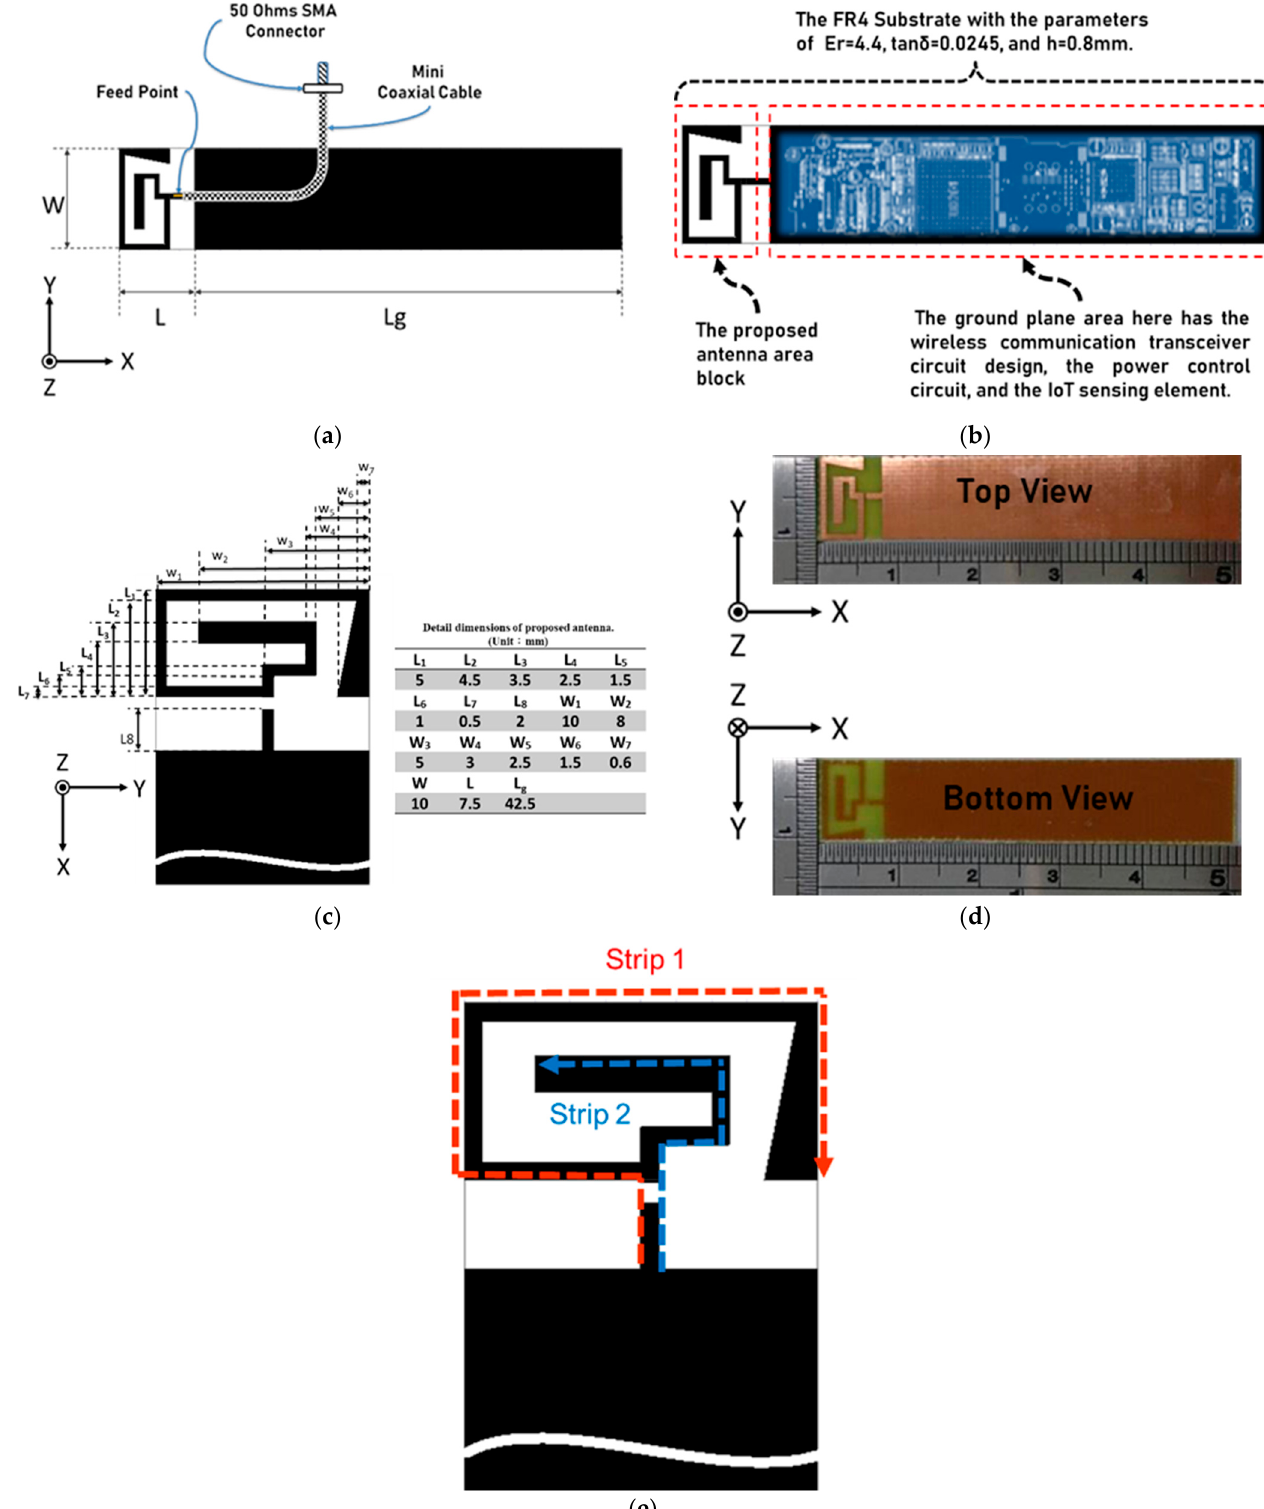
Figure 1. Disclosure of recommended antenna structure: ( a ) view of the antenna structure and overall design of the measurement layout, ( b ) schematic diagram of the layout applied to IoT devices; ( c ) detailed dimensions and layout of the antenna; ( d ) antenna entity diagram; ( e ) the clockwise spiral shape of two branches (Strip 1 and Strip 2). The main antenna area with the dimension of 10 × 7.5 mm, and the ground for system placement includes an integrated circuit with power, baseband, and wireless transceiver